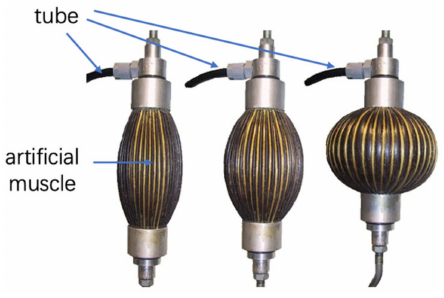
Figure 3. McKibben artificial